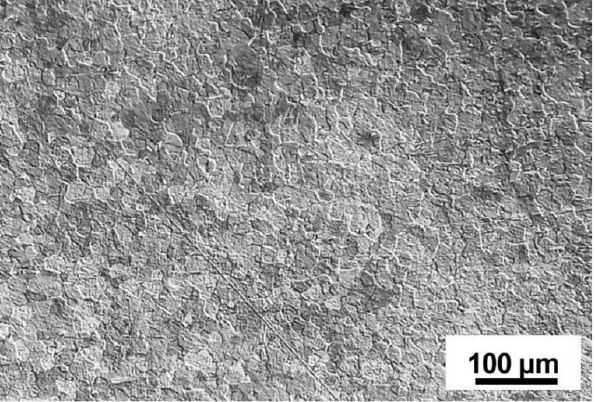
Figure 11. Microstructure of base alloy showing equiaxed α grains in prior β matrix.